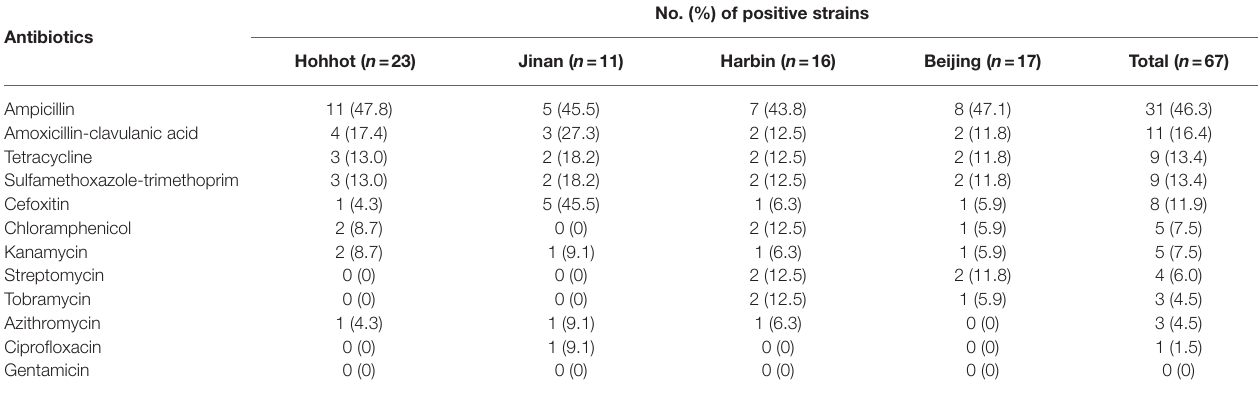
No. (%) of positive strains